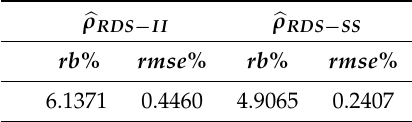
Table 4. Percent relative bias ( rb %) and the relative mean squared error ( rmse %) for estimating the correlation coefficient ρ with estimators (cid:98) ρ RDS − II and (cid:98) ρ RDS − SS for the ethnic example. (cid:98) ρ RDS −